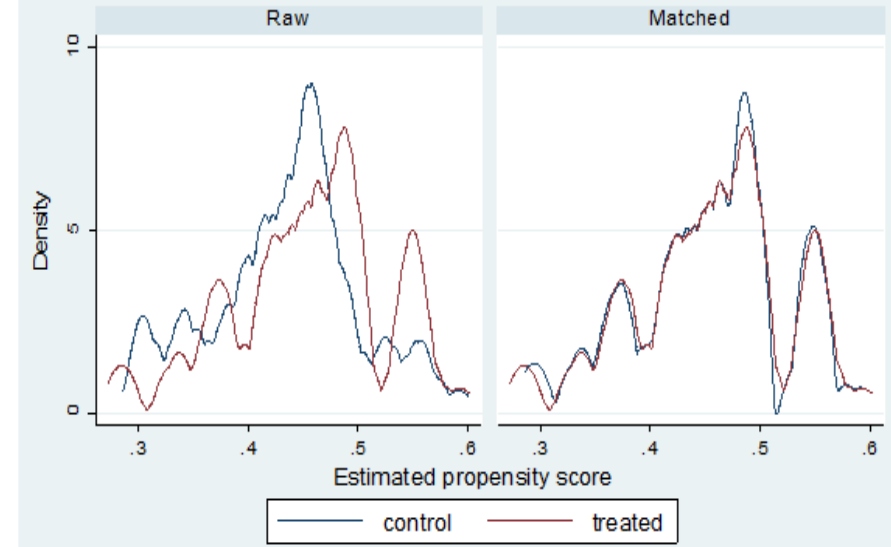
Figure 1: Distribution Of Estimated Propensity Scores of Treatment And Control Groups, Before And After